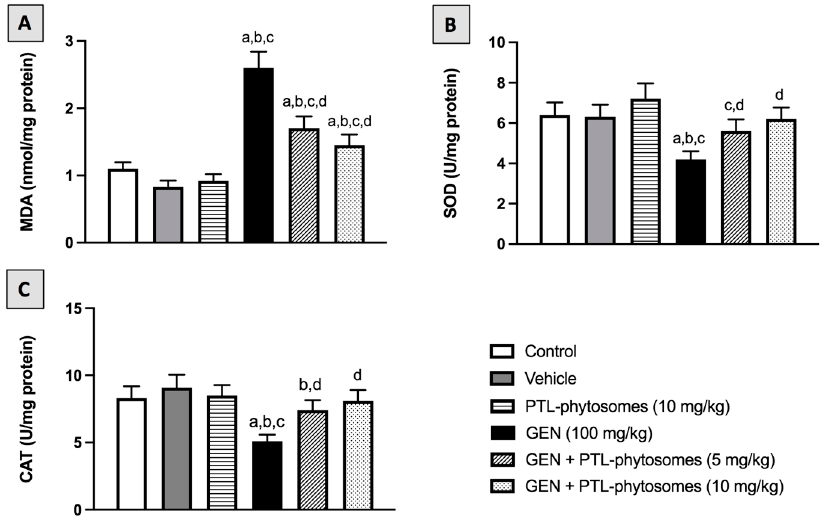
Figure 7. PTL-phytosomes restored oxidative stress markers in GEN-treated rats. ( A ) MDA, ( B ) SOD, and ( C ) CAT were used as oxidative status markers. Data are expressed as Mean ± SD ( n = 6). a: significant when compared to control at p < 0.05; b: significant when compared to vehicle at p < 0.05; c: significant when compared to PTL-phytosomes at p < 0.05; d: significant when compared to GEN-alone at p < 0.05.